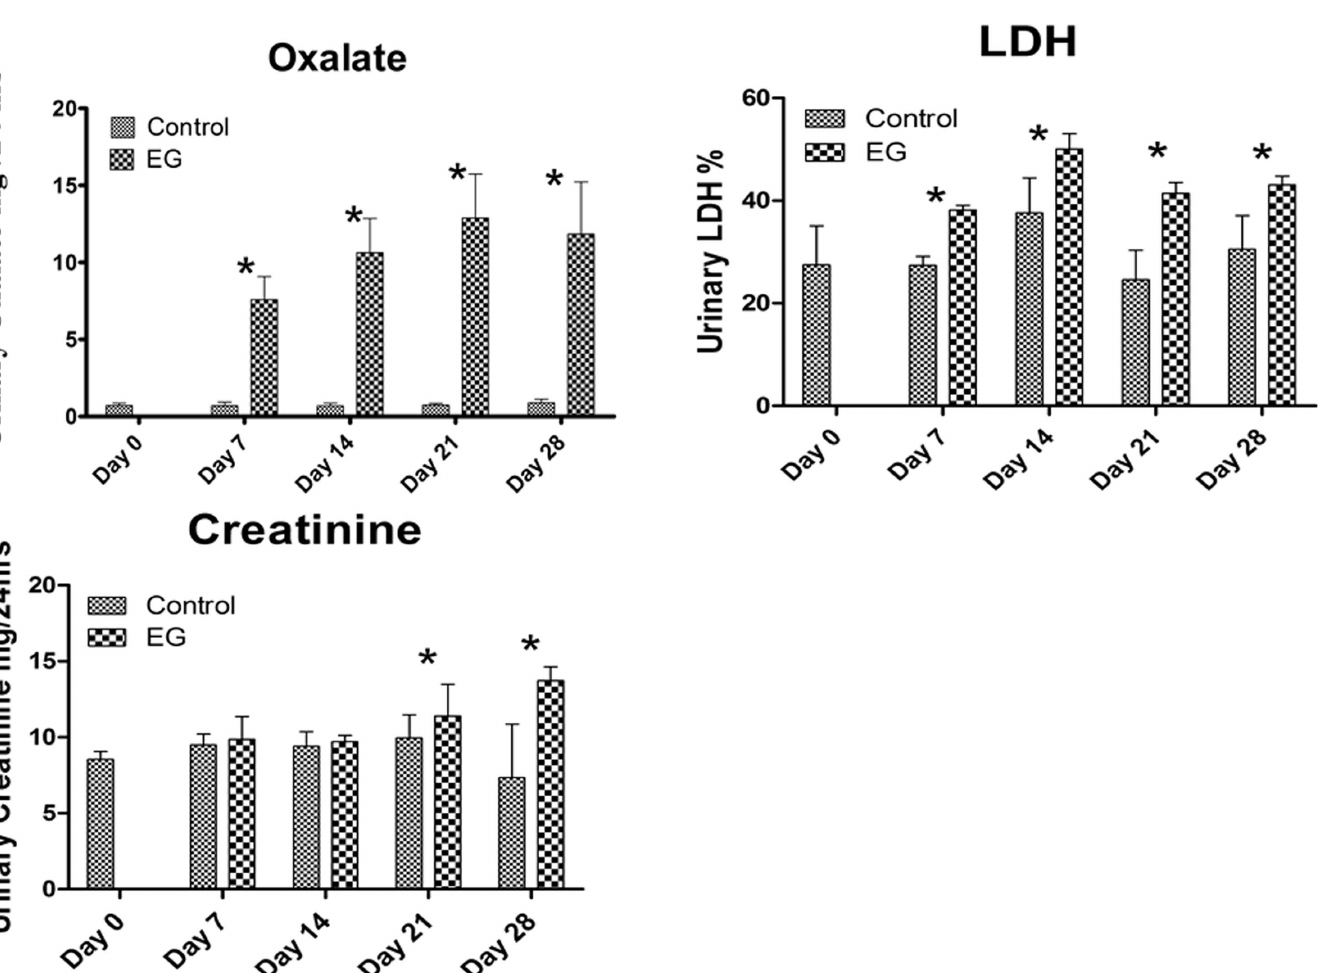
Fig 1. Urinary excretionof control and ethylene glycol (EG) treated rats. A) EG fed rats showedsignificantincreasein urinary oxalate (mg/24hrs) excretionon day 7, 14, 21 and 28 respectivelyB) Urinary Lactate Dehydrogenase (LDH) was elevatedin the EG fed rats on Day 7, 14, 21 and 28 respectively as comparedto the control rats, Cytotoxicity level of LDH was measuredas expressedas percentage(%) and C) Urinary Creatinine (mg/24hrs) was significantly higheron day 21 and 28 in the EG fed rats as comparedto the control group. The data was analyzedusing Graph Pad Prism with 2-way Analysis of Variance. * P < 0.05 Control versus EG within the same time